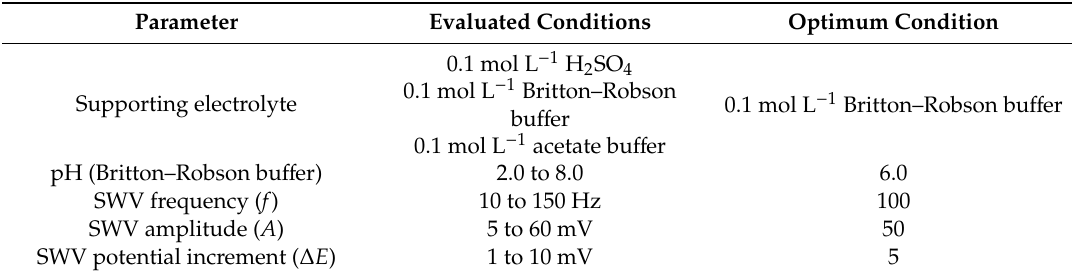
Table 1. Optimization of experimental conditions for chloroquine detection by square-wave voltammetry (SWV).